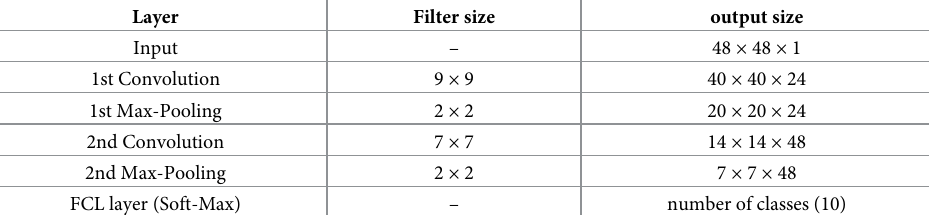
Table 2. CNNs layers